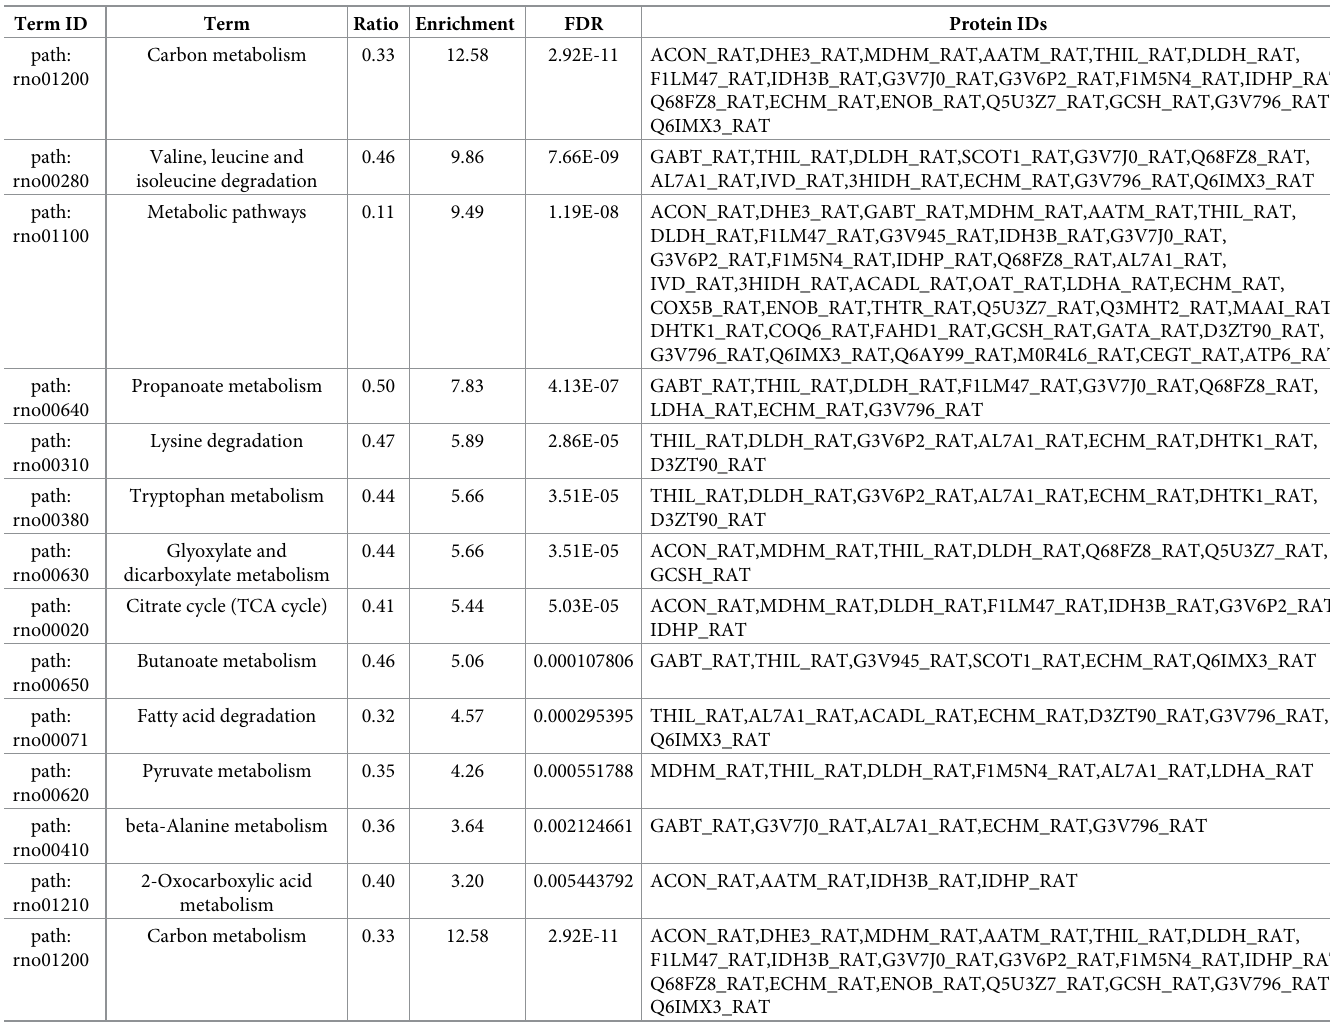
Table 5. The significantly enriched KEGG pathway from the